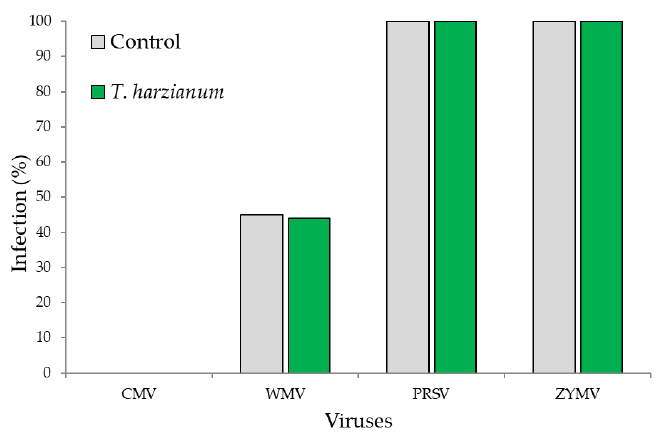
Figure 7. Percentage of infection for each virus determined by ELISA in zucchini plants.